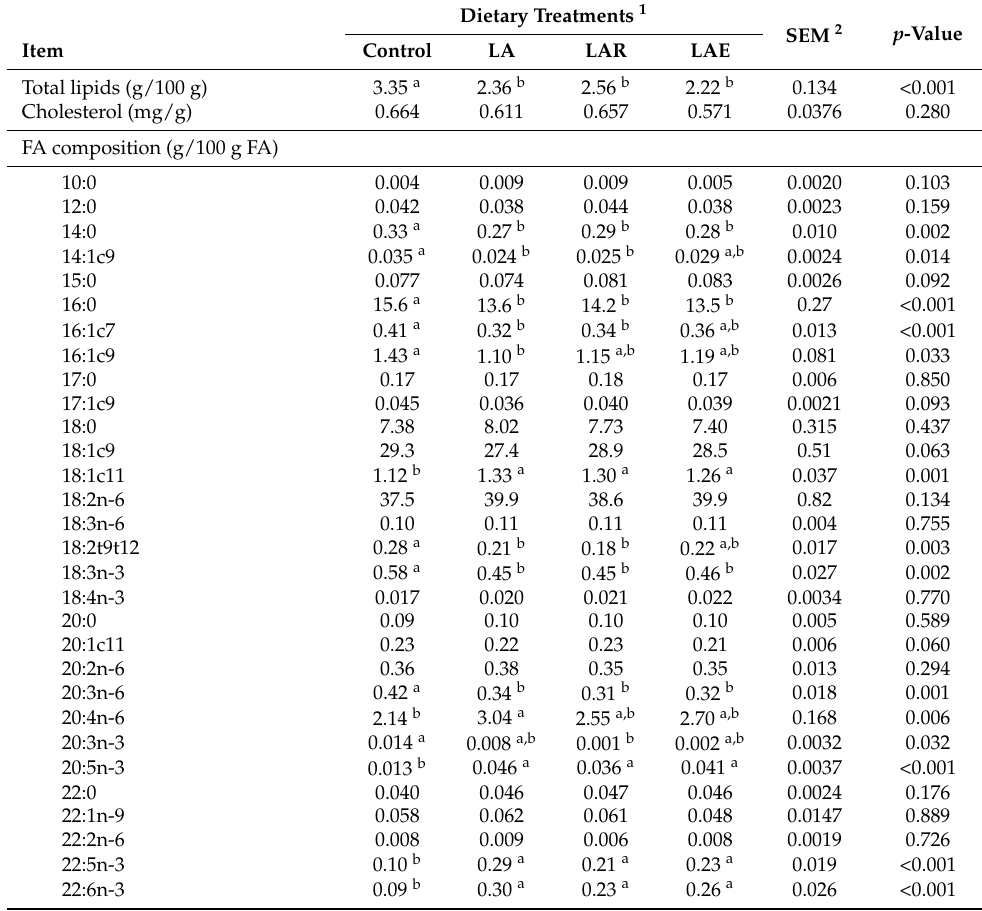
Table 8. Total lipid content, cholesterol content, and fatty-acid (FA) composition in the thigh meat of broilers ( n =